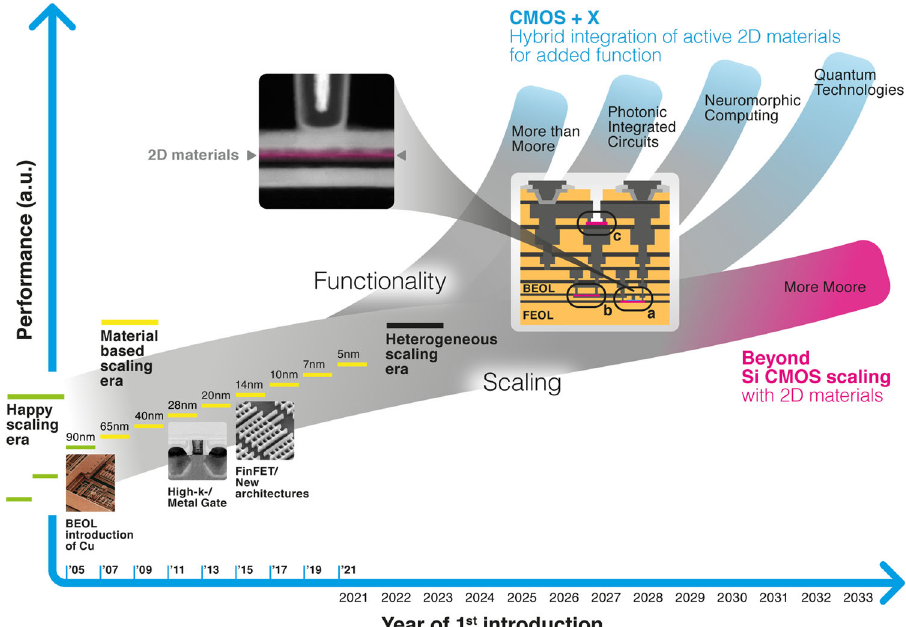
Fig. 1 The era of geometrical or Dennard 9 scaling of silicon technology ended around the turn of the century (green lines, “ happy scaling ” ). Since then, material and architecture innovations like copper interconnects 10 , high- k dielectrics with metal gates 11 and FinFETs 12 continued to drive Moore ’ s law (yellow lines, “ less happy scaling ” ). Future scaling, or “ More Moore ” , may require thin nanosheet transistors, where 2D materials are considered ideal candidates (magenta, inset a and transmission electron micrograph) 13,14 . Substantial performance and functionality gains are expected through “ CMOS + X ” integration, for example through sensors or high frequency electronics integrated on CMOS chips in the “ More Than Moore ” domain